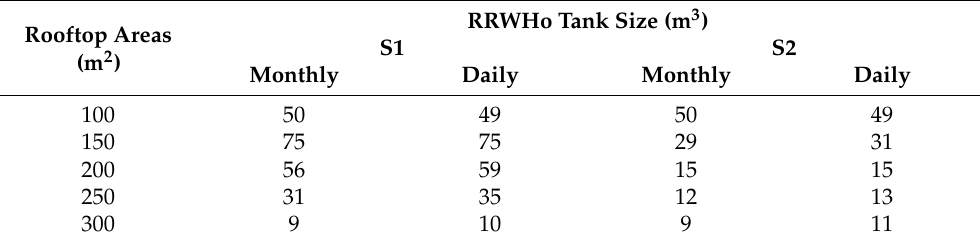
Table 5. Comparison between RRWHo values for Nablus governorate for the two scenarios and based on the monthly and daily rainfall data.